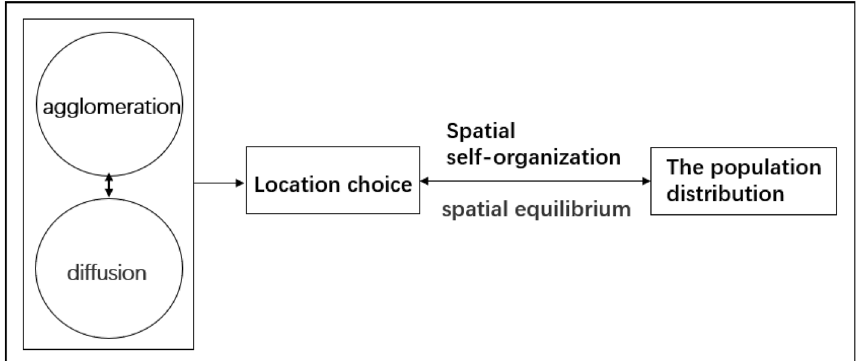
Figure 1. Influencing mechanism of population distribution.